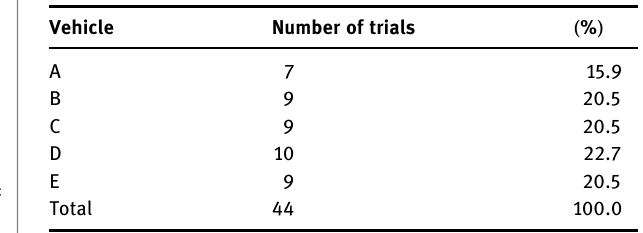
Table 1: The number of trials